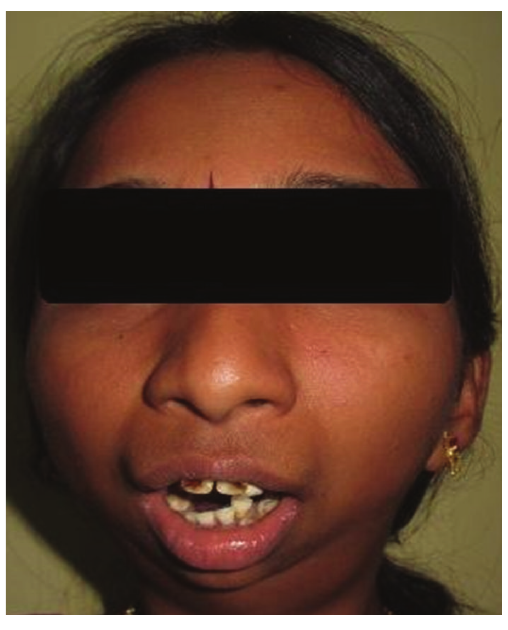
Figure 3: Restricted mouth opening.